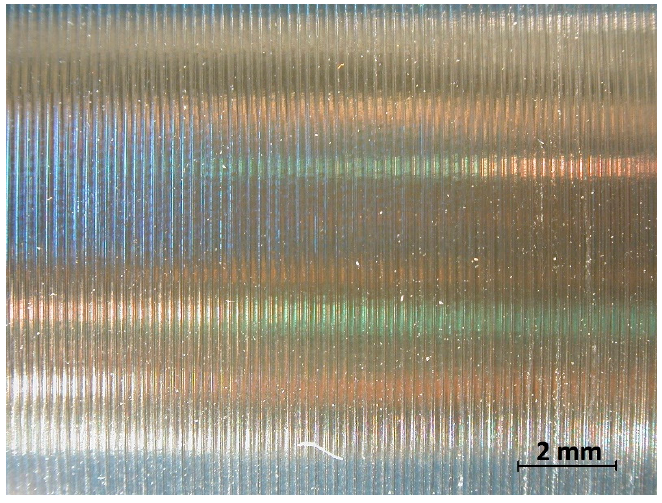
Figure 16. View of the machined surface after longitudinal turning without coolant (36 HRC).